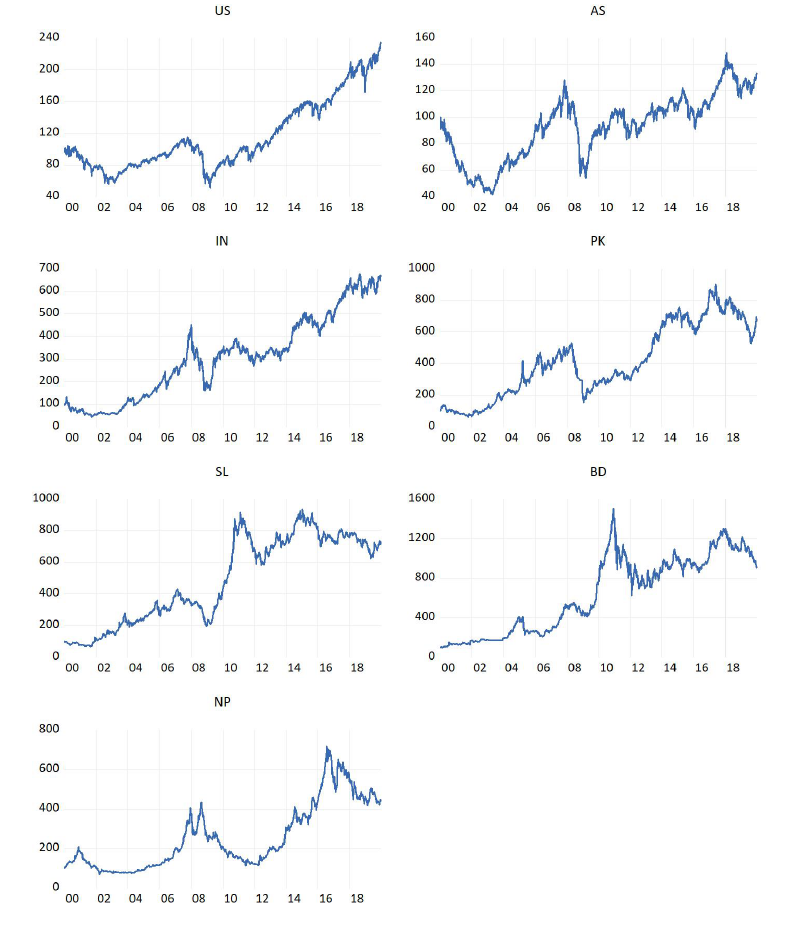
Figure 1. Equity market indices. This graph shows the evolution of the aggregate equity market indices for the sample countries. US, AS, IN, PK, SL, BD and NP refer to the US, Asia, India, Pakistan, Sri Lanka, Bangladesh, and Nepal respectively. The sample period is from 4 January 2000 to 31 December 2019. In each graph, x-axis shows the time and y-axis shows the index value. The equity indices are indexed to 100 at the beginning of the sample period. Data source: